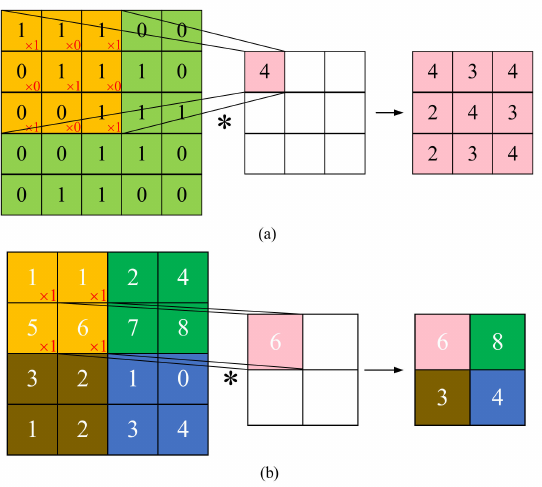
Figure 7. Schematic of the convolution and downsampling operation (( a ) is the convolution operation and ( b ) is downsampling